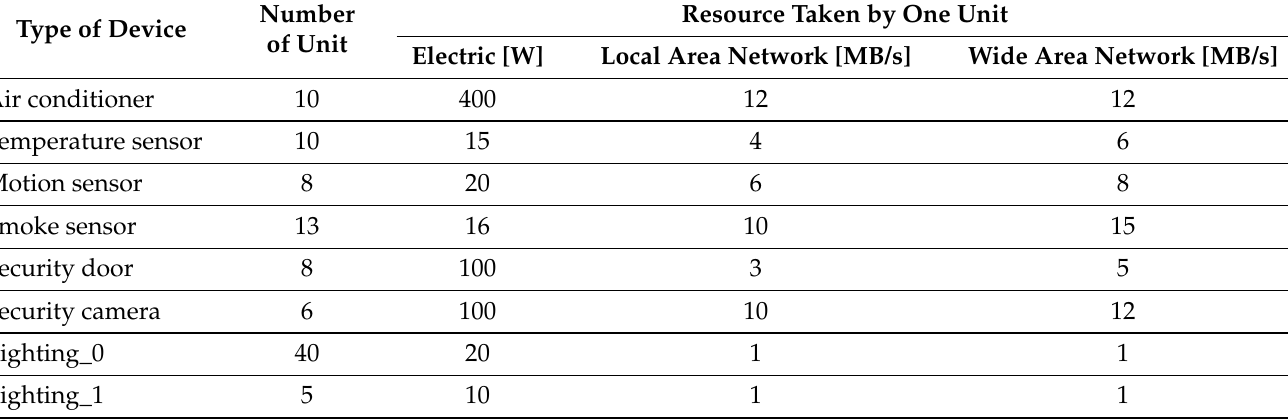
Table 6. Device parameters used in the